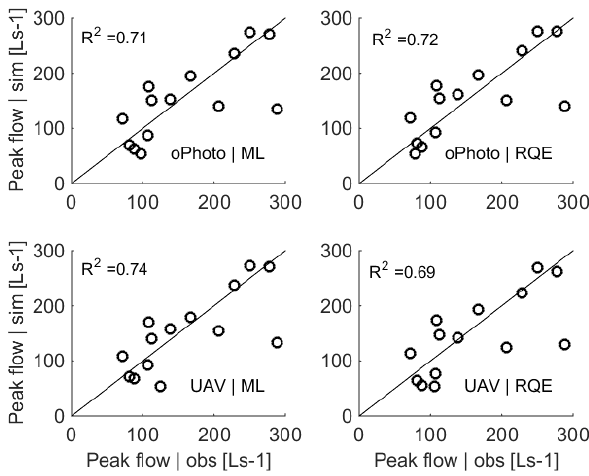
Figure 9. Evaluation of the peak flows for the 13 most intense rain events in the validation period (after